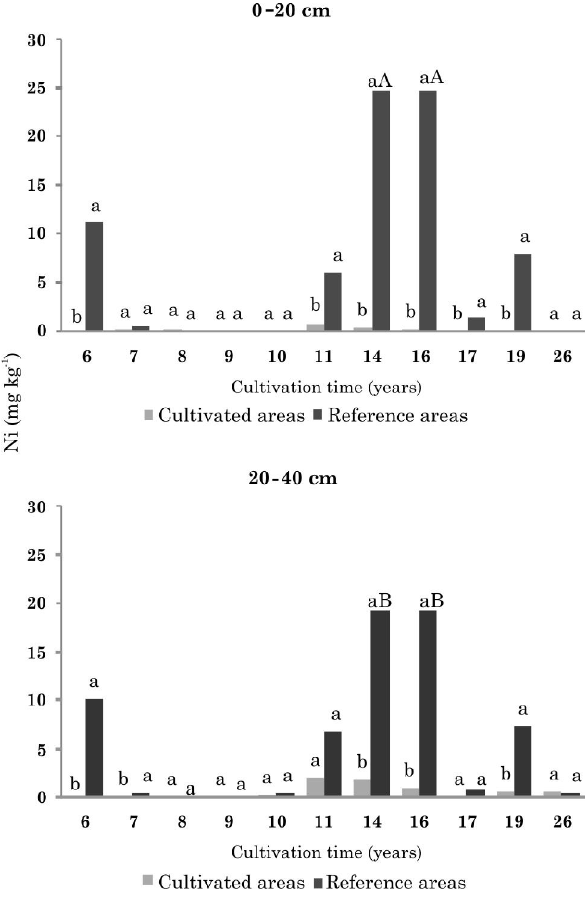
Figure 3. Total Pb contents in cultivated (CA) and reference areas (RA) in two layers (0-20 and 20- 40 cm) after different cultivation periods. Means followed by lowercase letters between environments (CA and RA) and capital letters between layers (0-20 and 20-40) did not differ statistically by Tukey’s test (p (cid:172)(cid:31)(cid:172)